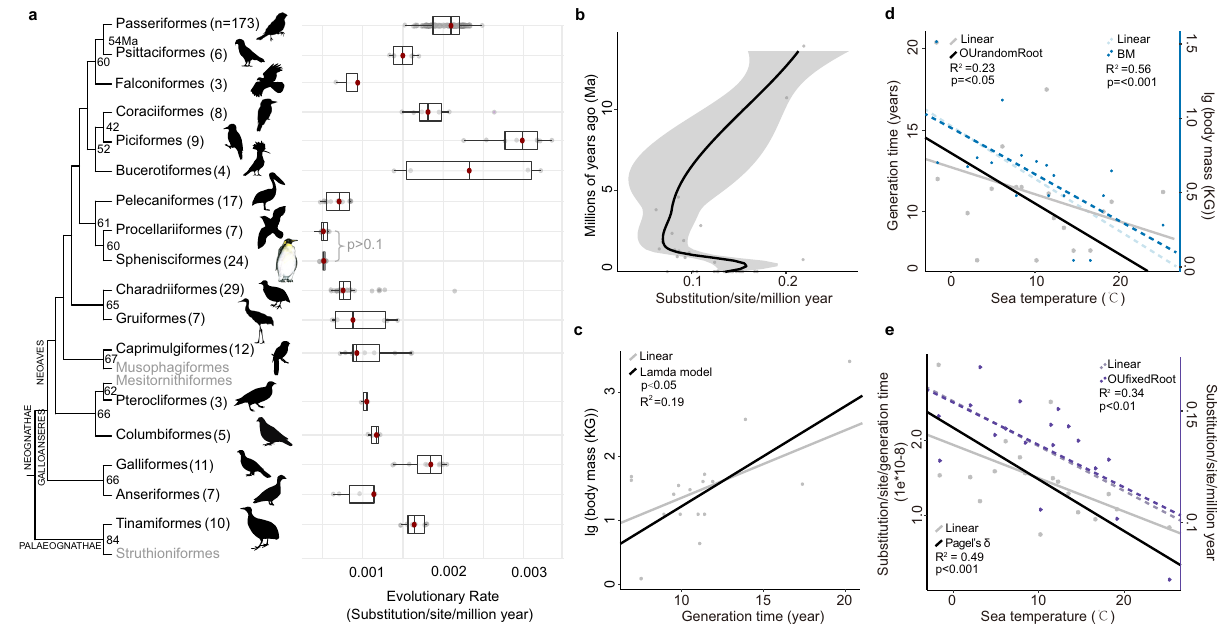
Fig. 3 Evolutionary rates in birds. a Evolutionary rate in avian orders based on a ~19 Mbp alignment of highly conserved genome regions. Sphenisciformes and Procellariiformes have the lowest evolutionary rate among modern bird orders (One-sided Wilcoxon Rank sum test, P values < 0.05 for all pairs except for Sphenisciformes and Procellariiformes ( P -values > 0.1)). Numbers at the tips represent the sample size in each group. Numbers at nodes represent the divergence times (Ma) between each order and its sister taxon and red dots within the boxplots indicate average values. We did not attempt to estimate the evolutionary rates for orders containing less than three sampled species (gray font; Musophagiformes, Mesitornithiformes, and Struthioniformes). Boxplots show the median with hinges at the 25th and 75th percentile and whiskers extending 1.5 times the interquartile range. Some bird images were downloaded from phylopic.org and were licensed under the Creative Commons (CC0) 1.0 Universal Public Domain Dedication. b Evolutionary rates inferred for extant penguin lineages at internal nodes from the maximum clade credibility tree, calculated using a 500 Mbp genome alignment. Gray shadows represent the 95% credible intervals. c – e Correlations between c , body mass and generation time ( P value < 0.05), d generation time (gray dots, solid lines, P value < 0.001) or body mass (blue dots, dashed lines P value < 0.05) and average sea surface temperature, e substitution per site